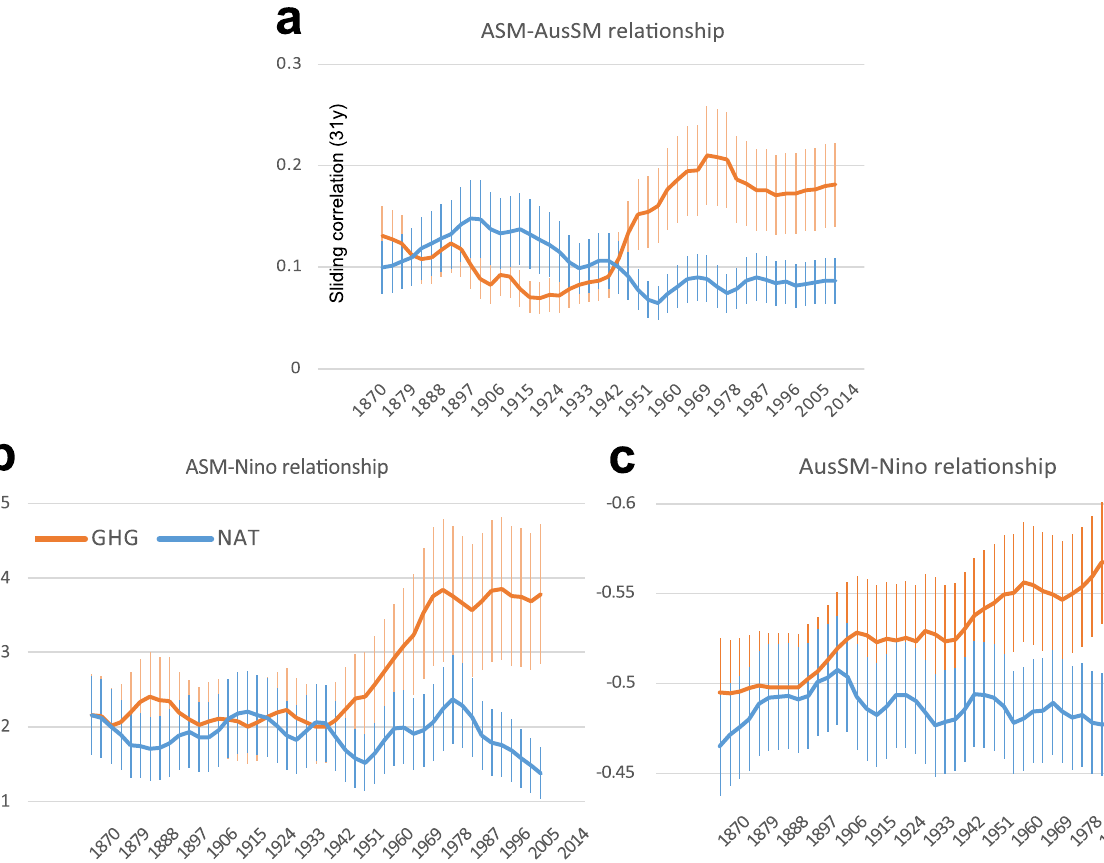
Fig. 4 ASM-AusSM and monsoon-ENSO relationship from CMIP 6. a 31-year running correlations between ASM and AusSM precipitation. b 31-year running correlations between ASM precipitation and ENSO. c 31-year correlations between AusSM and Nino from CMIP 6. Error bars represent two standard deviations from the mean. The running correlations are centered. The number of models/members used here is ( a ) 26, ( b ) 28, and ( c ) 26 out of the 50 total models listed in Supplementary Table 5 (see